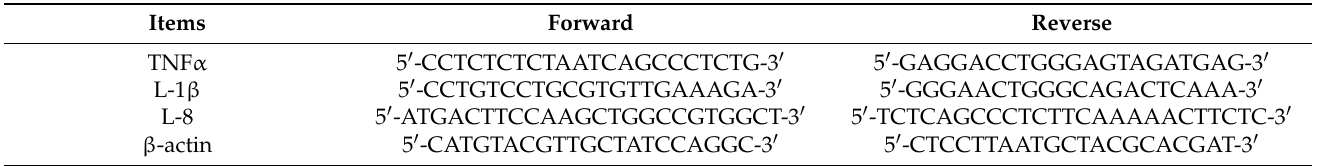
Table 1. Oligonucleotides sequences of forward and reverse primers used in PCR real